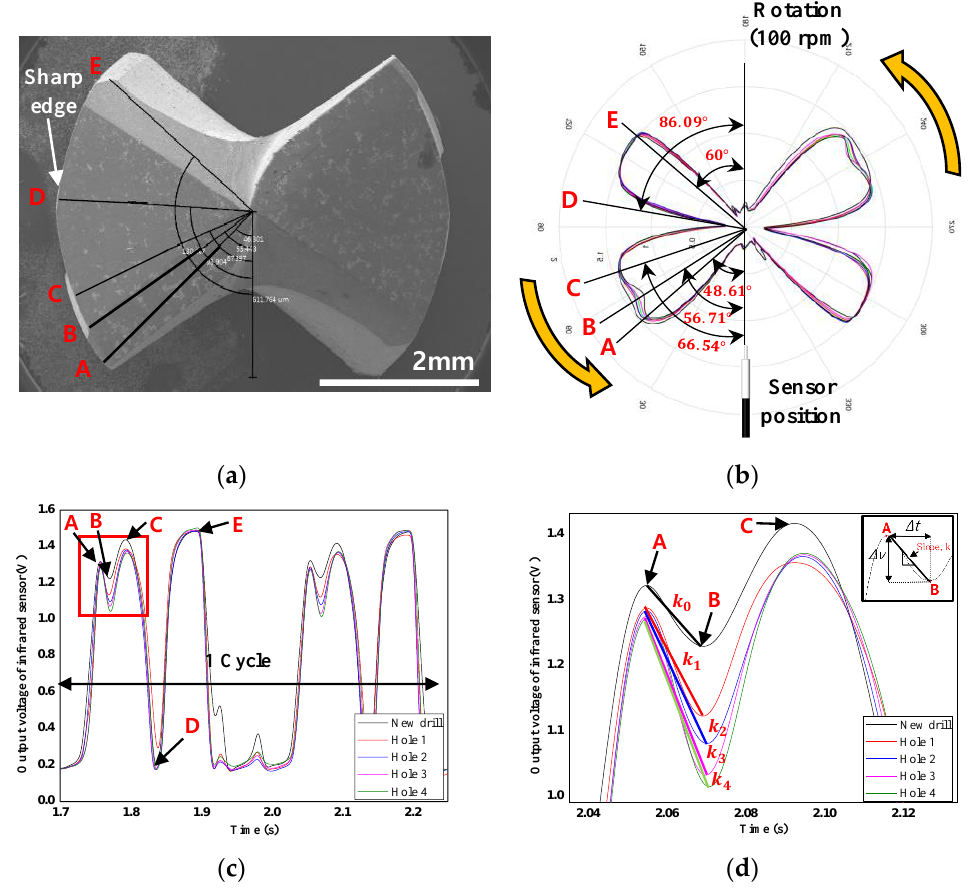
Figure 6. ( a ) Scanning microscope micrograph of the TiAlN-coated carbide twist drill bit before use. ( b ) Polar axis graph of reflected infrared light intensity during one drill bit rotation at 100 rpm. ( c ) Time-domain graph of reflected infrared light intensity during one drill rotation at 100 rpm. ( d ) Magnification of ( c ).